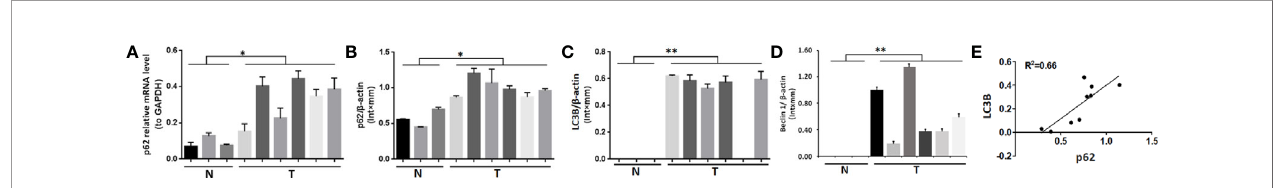
FIGURE 1 | Expression of p62, LC3B and Beclin 1 in bone metastasis tissues of lung adenocarcinoma. (A, B) Both p62 mRNA and protein expression levels were higher in tumor tissues (T) than in normal cancellous bone tissues (N). (C) LC3B and (D) Beclin 1 protein expression levels were higher in tumor tissues (T) than in normal cancellous bone tissues (N). (E) Positive correlation between p62 protein expression and LC3B protein expression (P=0.005). T, bone metastasis tissues; N, normal cancellous bone tissues. *P < 0.05, **P < 0.01